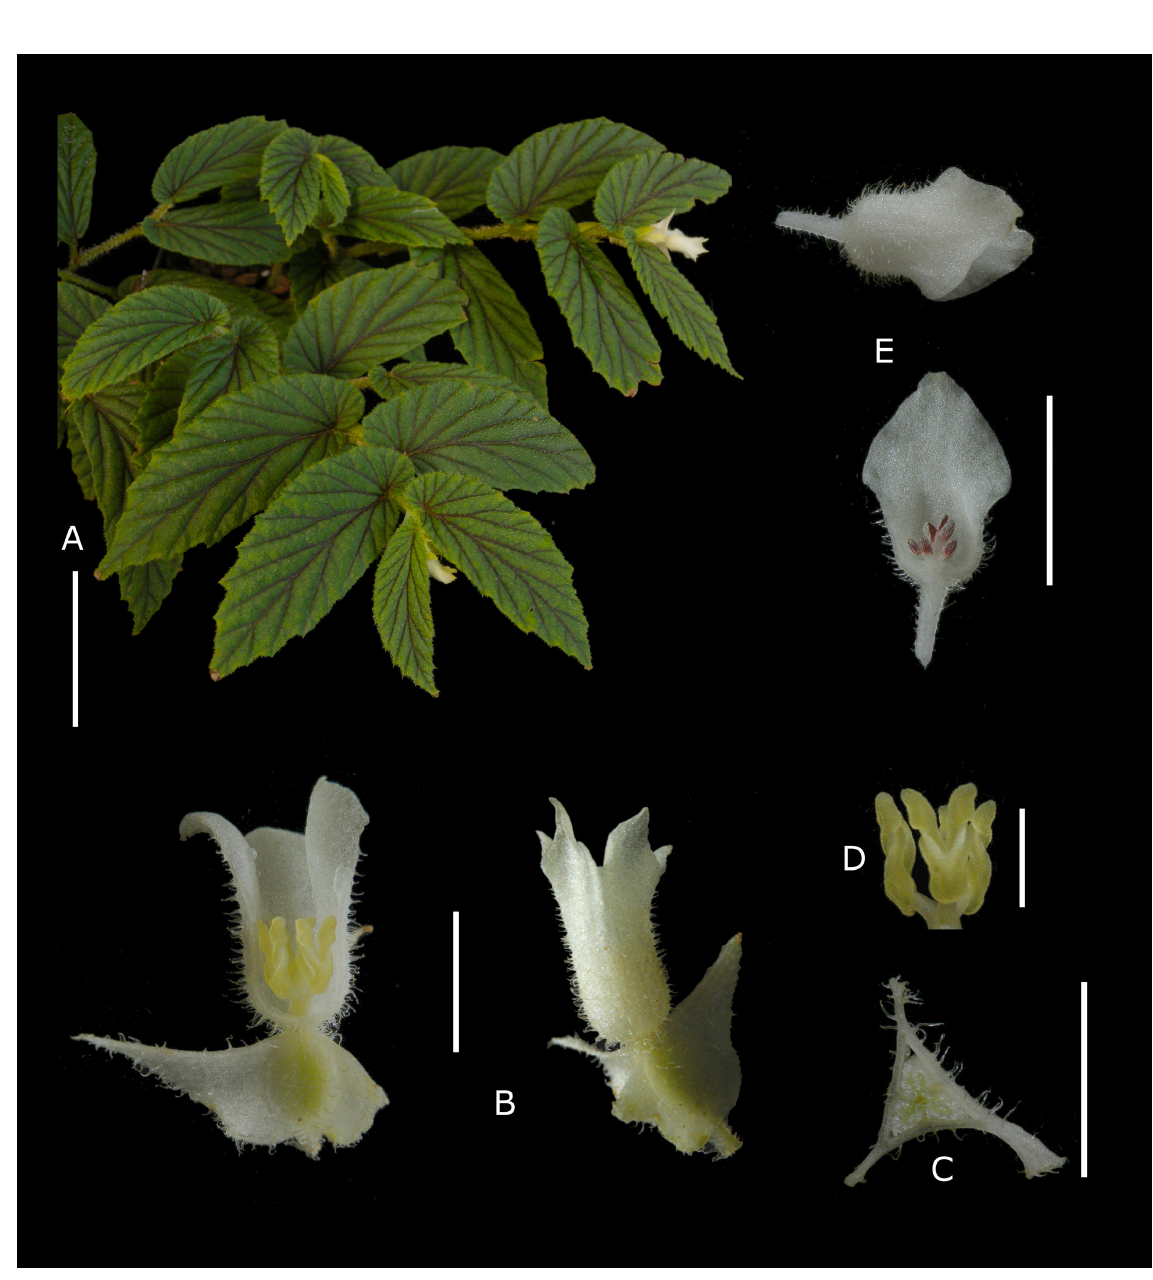
Fig. 1. Begonia yapenensis M.Hughes sp. nov., cultivated specimen at the Royal Botanic Garden Edinburgh, accession 20090830. A . Whole plant showing spreading habit (scale bar = 5 cm). B . Female flower and ovary (left, corolla dissected; right, corolla entire) (scale bar = 1 cm). C . Cross section of ovary showing three locules with bilamellate placentae (scale bar = 1 cm). D . Stigmas (scale bar = 5 mm). E . Male flower (bottom, corolla dissected; upper, corolla entire; scale bar = 10